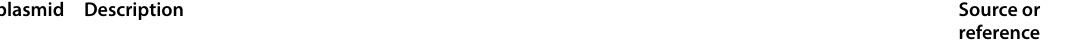
Table 1 Strains and plasmids used in this study Strain or plasmid